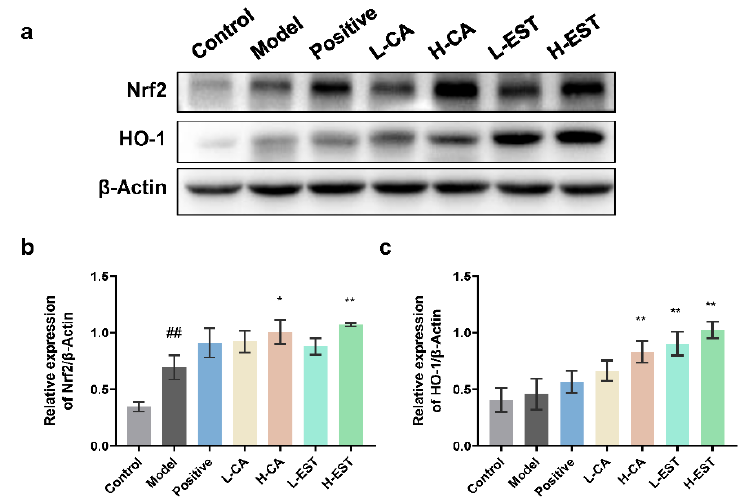
Figure 4. EST and CA decrease the CCl 4 -induced oxidative stress by activating the Nrf2/HO-1. ( a ) Western blotting analysis of Nrf2 and HO-1 expression in liver tissues and densitometric quantification of Nrf 2 ( b ) and HO-1 ( c ) ( n = 3). Data are expressed as mean ± SD. ## p < 0.01 compared with the control group; * p < 0.05, ** p < 0.01 compared with the model group.